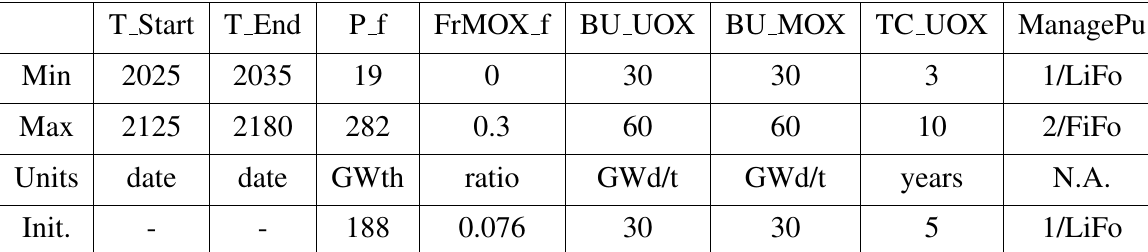
Table 1: Input space considered for application for the Wide Parametric Sweeping